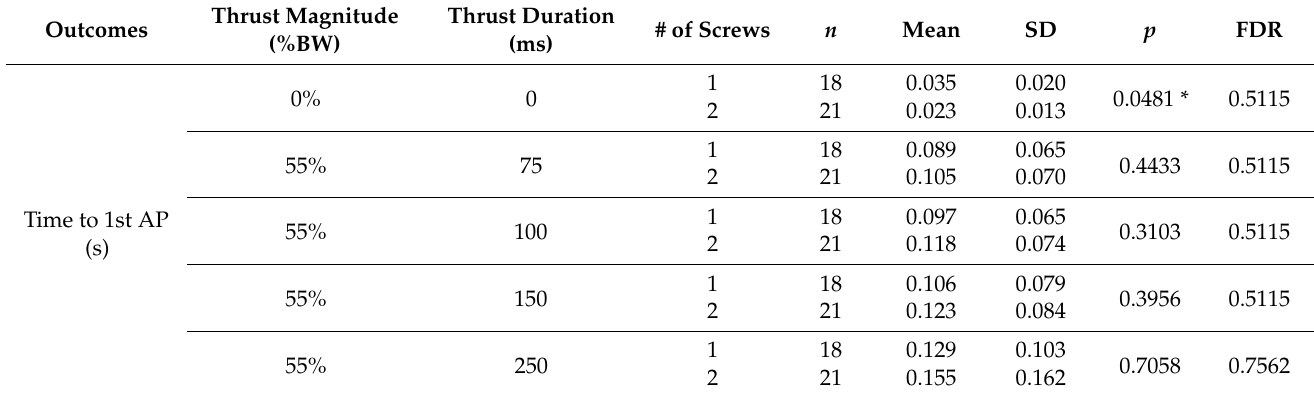
Table 1. Thrust duration comparisons between 1 and 2